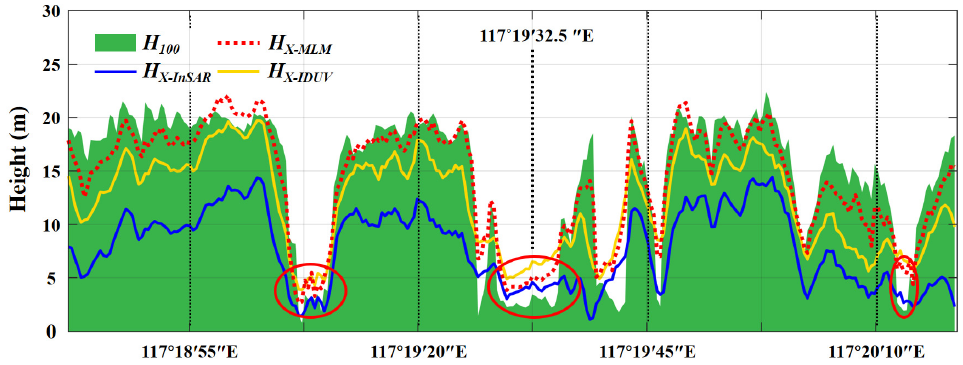
◦ 24 (cid:48) 20 (cid:48)(cid:48)